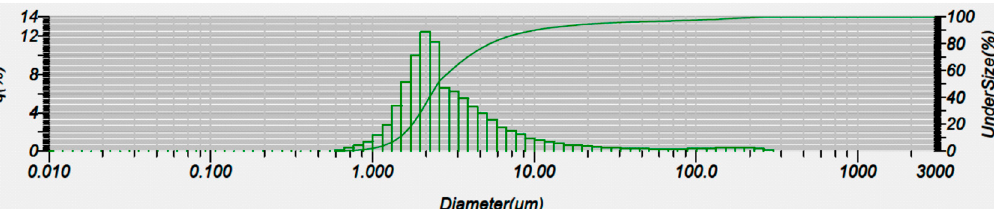
Figure 6. Normal distribution of FA.